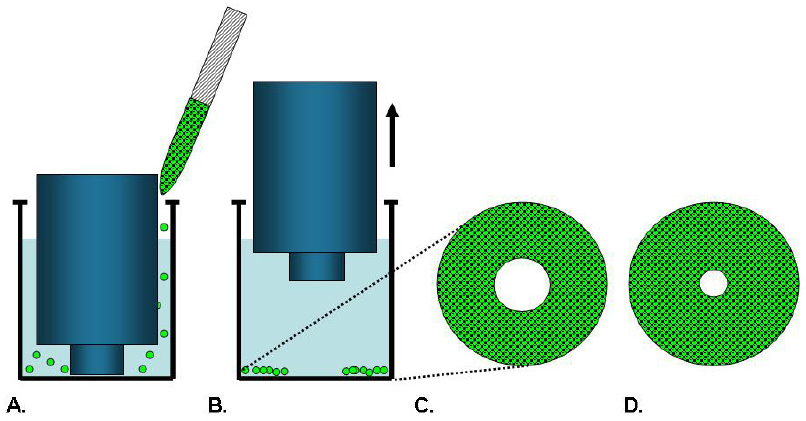
Figure 4. Cell Exclusion Zone Assay. Cells are seeded around a barrier ( A ) and adhere to the well bottom. The barrier is removed ( B ) to reveal a void available for cell movement. The cells are imaged at pre-migration ( C ) and after cells have migrated inward to fill the void ( D ). Assay options include coating the assay well with a matrix and adding an overlay of matrix to create a 3-dimensional